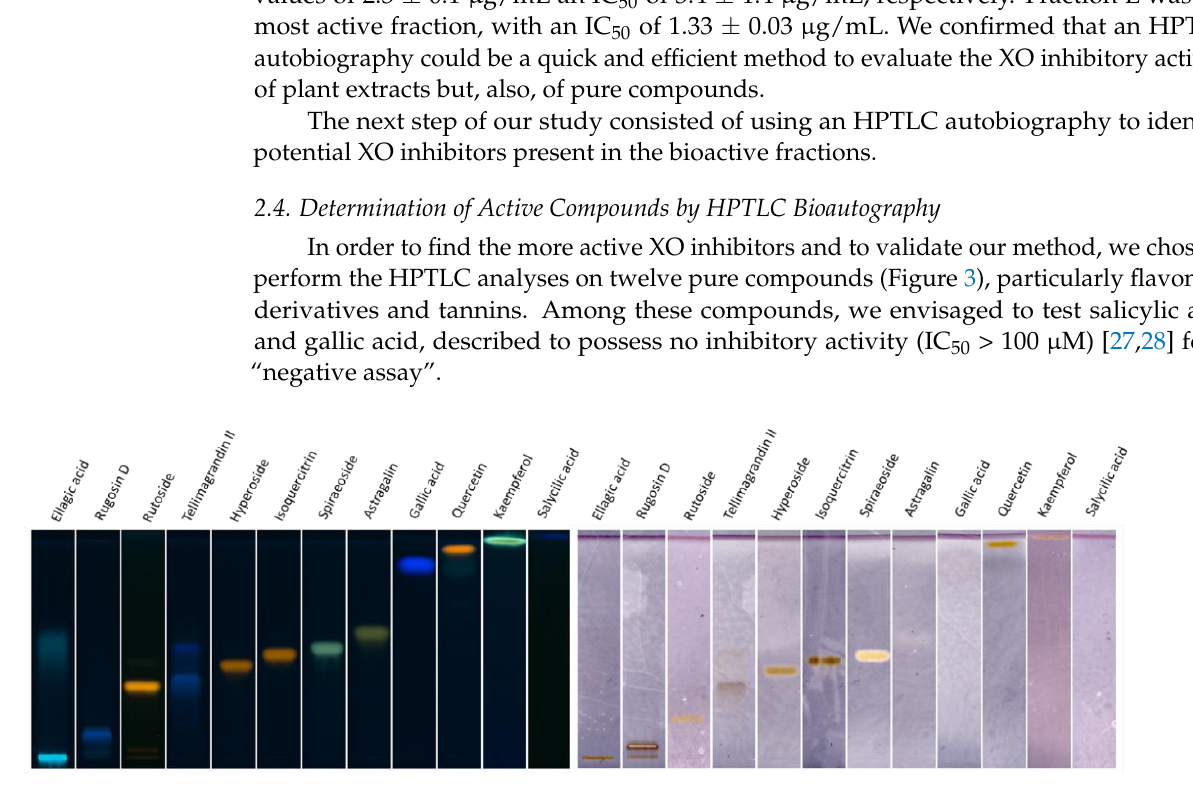
Figure 3. HPTLC analyses with NP-PEG derivatization ( left ) and XO bioautography ( right ) of 12 pure compounds .